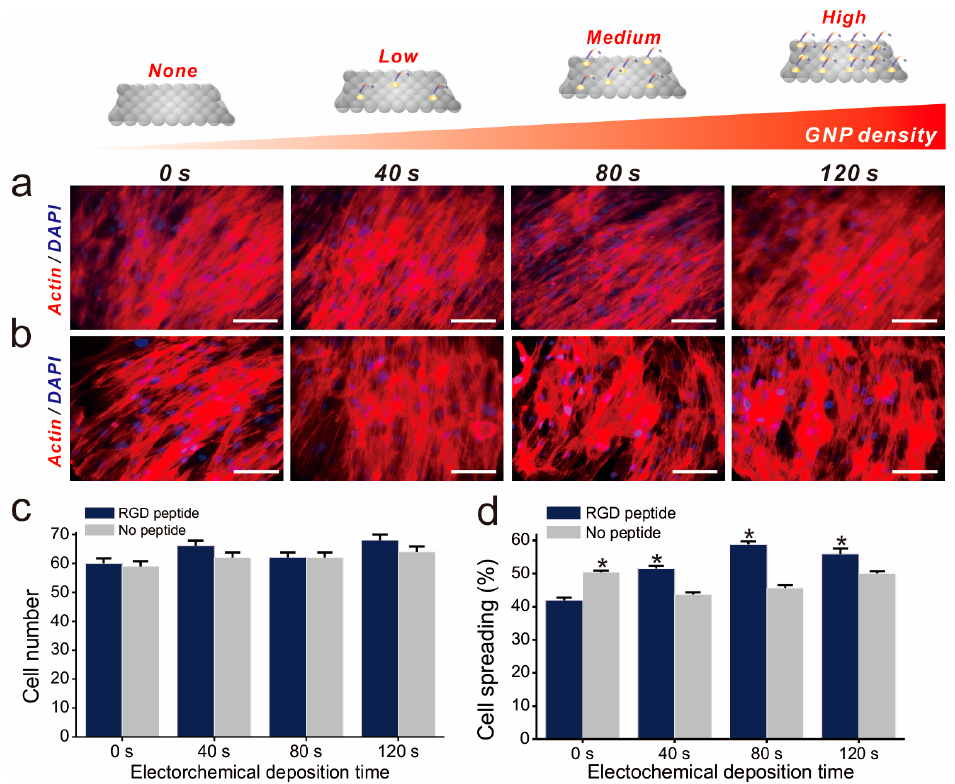
Figure 4. Fluorescence images of all substrates Fluorescence images of each substrate with ( a ) and without ( b ) RGD peptide. Scale bars = 100 µ m; ( c ) Number of cells on each substrate after 2 day of incubation; ( d ) Spreading of proliferated cells. * Student’s t -test, p < 0.05, n =